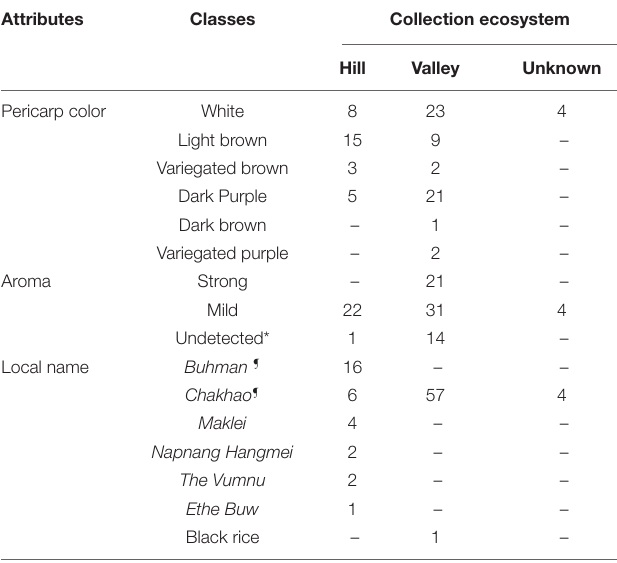
TABLE 1 | Distribution of aromatic genotypes based on the various locations from which they originated in Manipur, included in the panel of genotypes used in the study based on a priori information such as pericarp color, aroma, ecosystem, and local